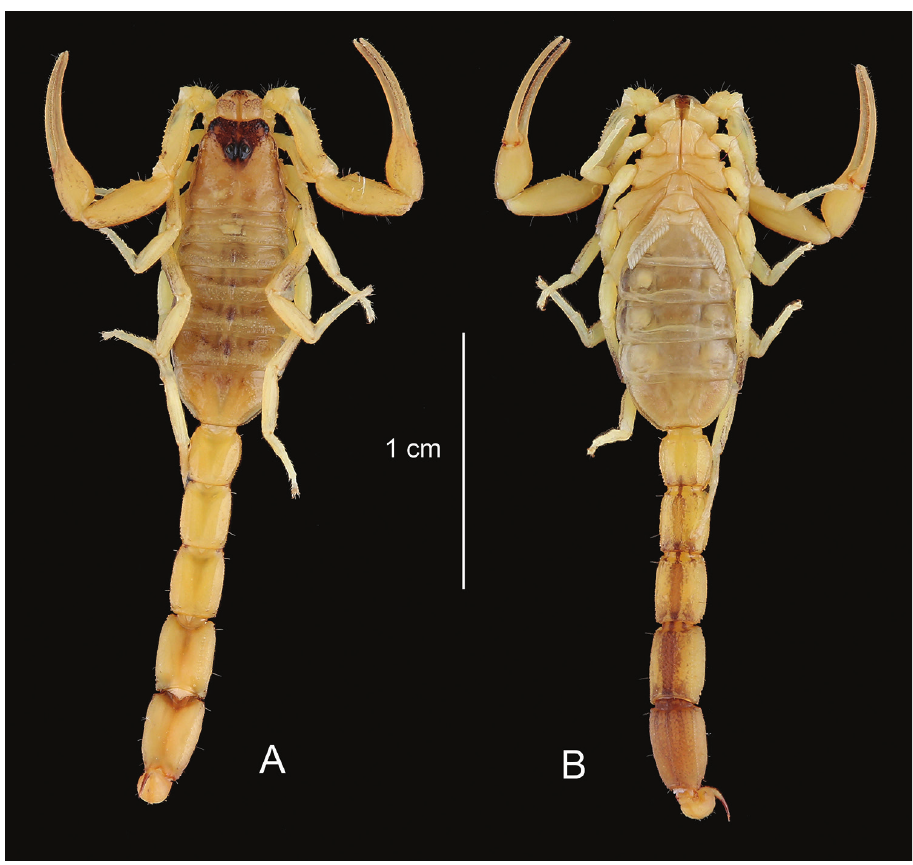
Figure 8. Physoctonus debilis . Habitus of female from Caxias, Maranhão, Brazil, dorsal and ventral aspects.